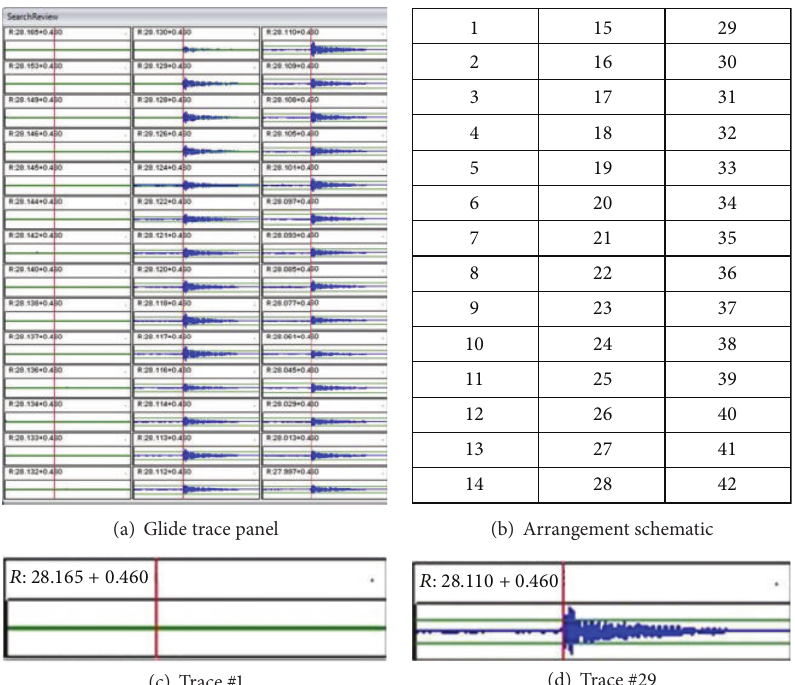
Figure 5: Signal analysis panel illustrating the “Glide Edge Finder” algorithm with signal at 42 tracks. The first track with the glide signal is track no. 15 with a radius of 28.130 mm. (a) Glide signal panel showing the signal at each track arranged in descending order of the radius. (b) Schematic of the track arrangement. (c) Signal trace at track no. 1 with the radius equal to 28.165 mm. No signal due to defect is present. (d) Signal trace at track no. 29 with the radius equal to 28.110mm. Peak signal from defect is present. The starting radius with defect signal defines the edge, 28.130 mm. The value 0.460 mm is the glide head edge offset. The angle is obtained from the averaging of the peak angular position of the data, shown as the red line in